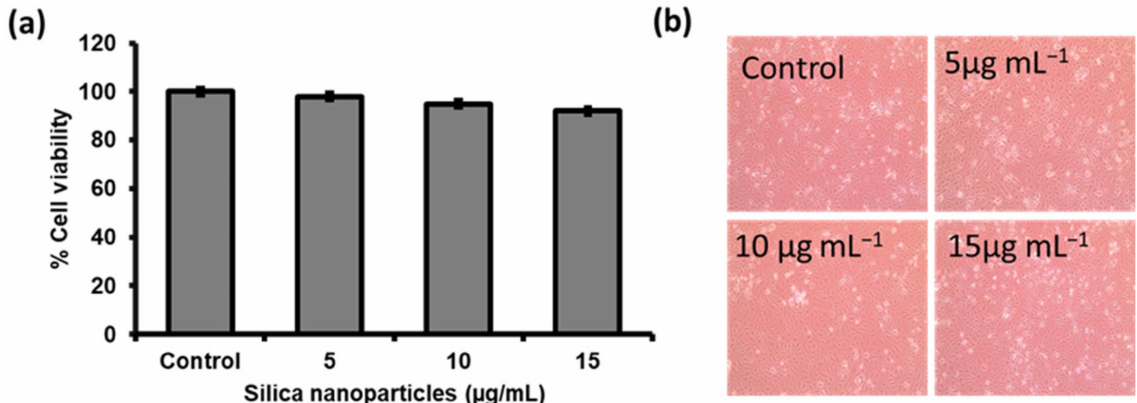
Figure 6. Biocompatibility/cytotoxicity of the synthesized